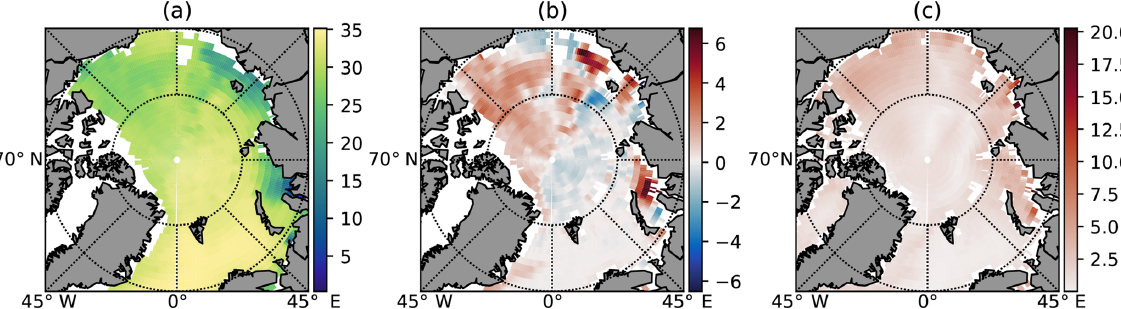
Figure 8. (a) Average surface salinity in based on Sumata et al. (2018) observed climatology, (b) mean departure of the four-ocean reanalysis from the climatology selected from Uotila et al. (2018), and (c) the salinity spread of the four-ocean reanalysis. The figure illustrates that the Arctic Ocean salinity uncertainty is the highest on the Siberian shelf, in particular close to the large rivers. This high uncertainty highlights the need for more measurements from the